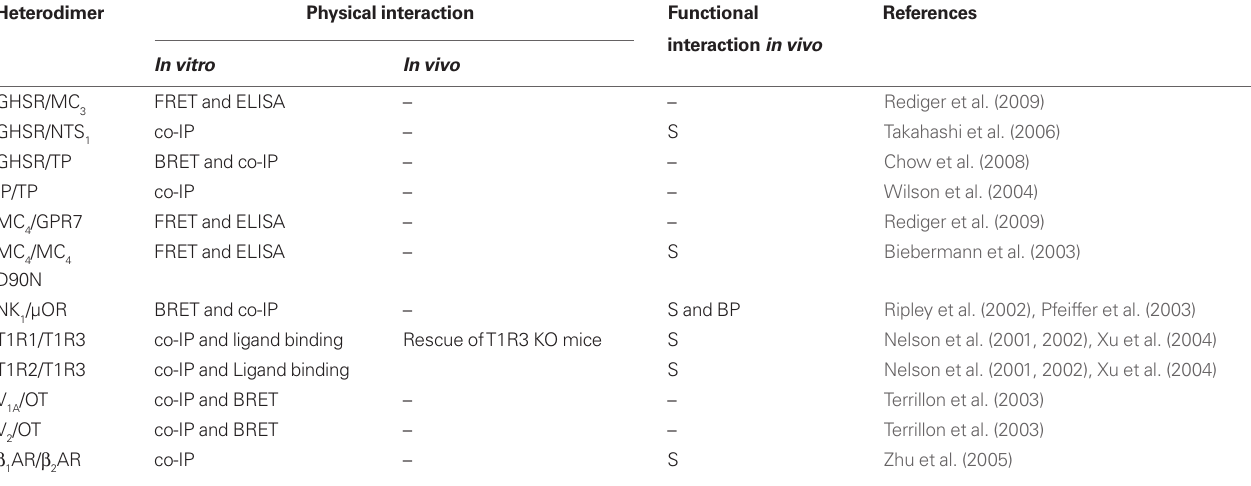
This table enumerates the major GPCR heteromers and details the, in vitro and in vivo, evidence for physical interaction, if present. S, signaling modulation; T, trafficking modulation; B, binding modulation; E, expression modulation; BP, Behavioral or pain modulation in mice; BRET, bioluminescence resonance energy transfer; FRET, fluorescence resonance energy transfer; co-IP, co-immunoprecipitation; β AR, beta adrenergic receptor; EP receptor; μOR, mu opioid receptor; δ OR, delta opioid receptor; 5-HT receptor 4; Gal, galanin receptor; mGlu, mGlutamate receptor; A, adenosine receptor; P2YR, purinergic P2Y receptors; AT, angiotensin receptor; APJ, apelin receptor; B, Bradikinin receptor; CB, canabinoid receptor; OX, orexin receptor; CCR5, C-C chemokine receptor type 5; CXCR4, C-X-C chemokine receptor type 4; CRF corticotrophin releasing factor receptor subtype 1; H calcium-sensing receptor;